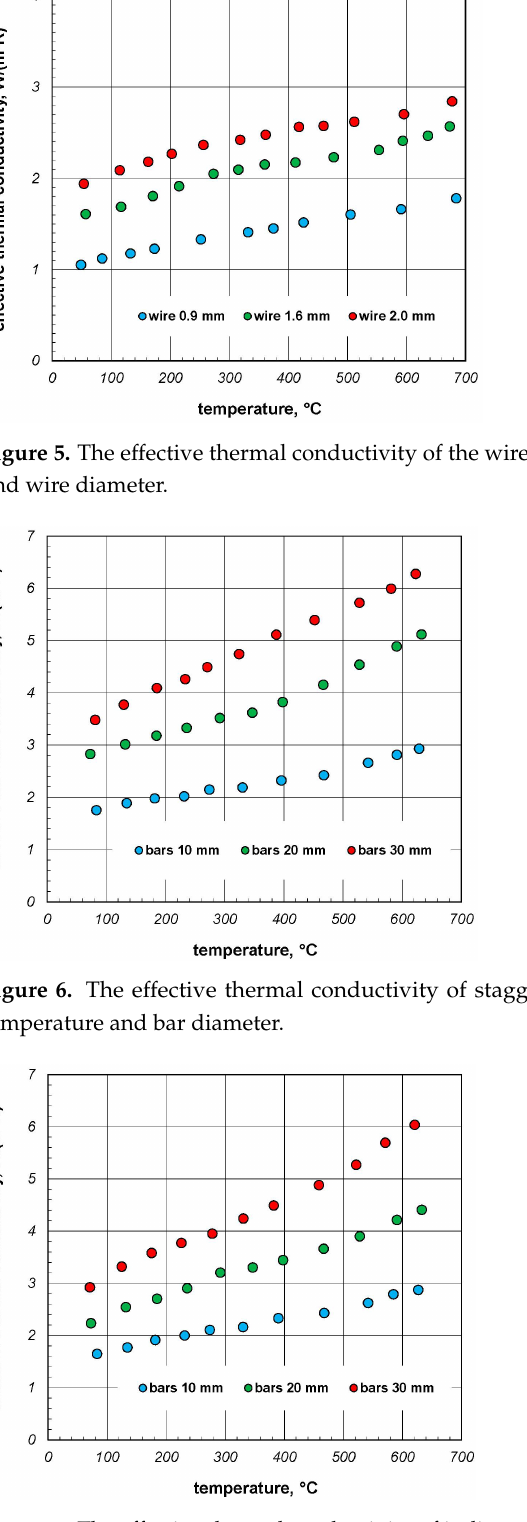
Figure 7. The effective thermal conductivity of in-line round bar samples depending on the tempera- ture and bar